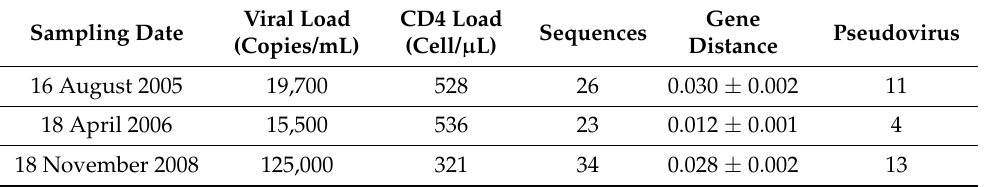
Table 1. The profile of the study subject